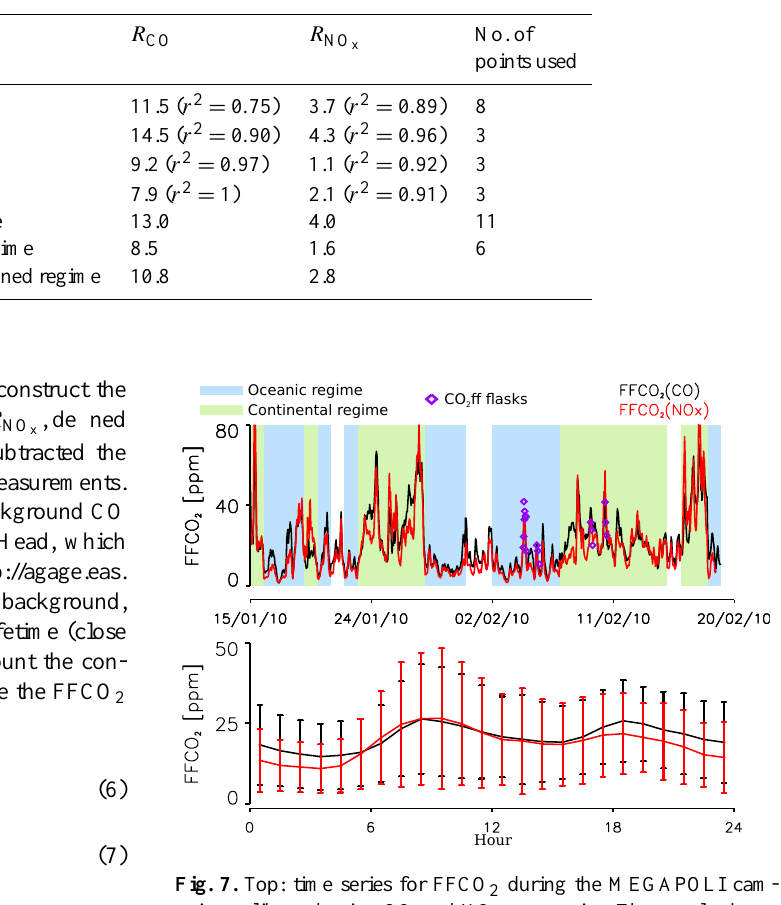
observed during the evening and over night (from 17:00 until 06:00 UTC) because of the short lifetime of NO x relative to the lifetime of